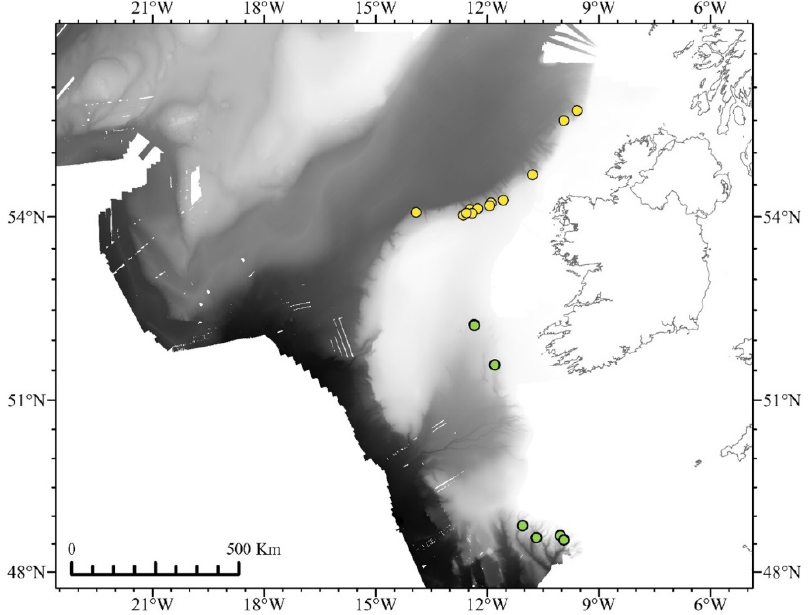
Figure 1. Locations of ROV dives that collected octocorals from 2017 (green circles) and 2018 (yellow circles). Bathymetry from INFOMAR and Ross et al. [38] . Visualized in ArcGIS Pro [39].